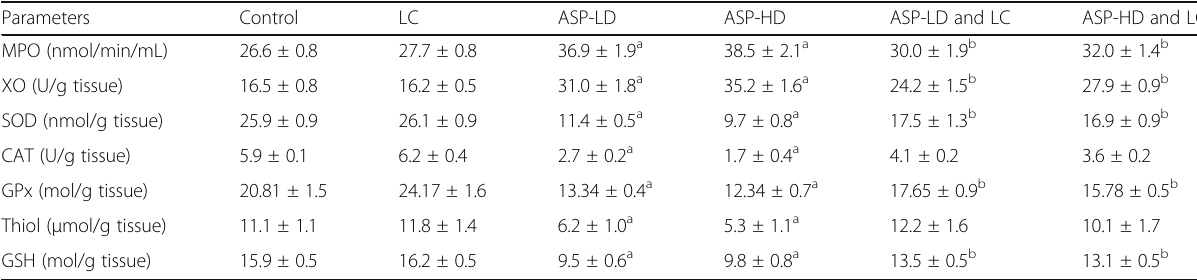
Table 1 Effect of L -carnitine on antioxidant enzymes, glutathione and thiol level in the brain of male rats treated with aspartame